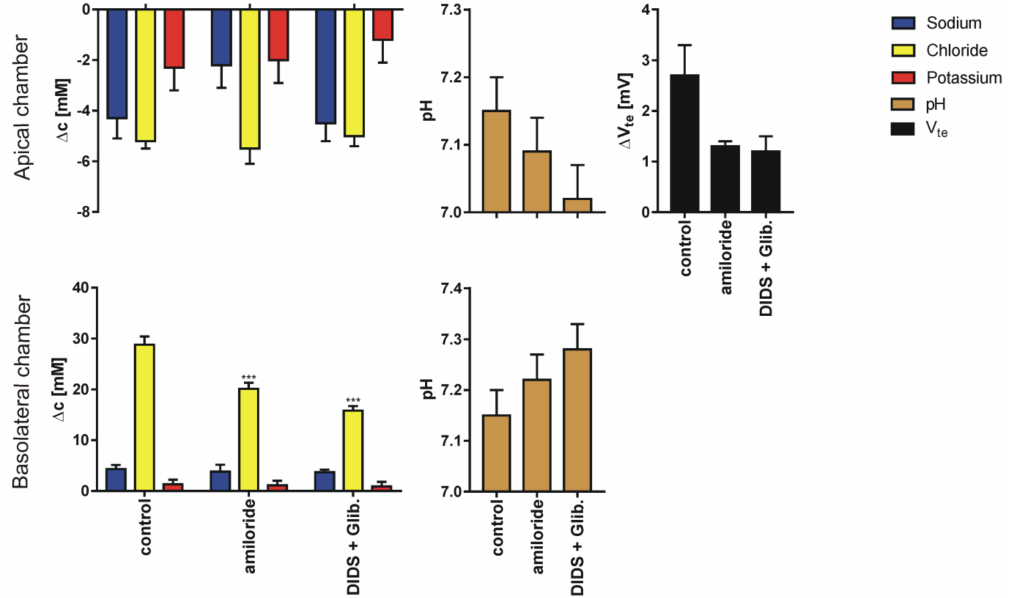
Figure 6. The results (Mean ± SD) of experiments performed in reversed chloride gradient (apical side, KHS1; basolateral side, KHS3) in control conditions and after supplementation of the solution with ion channel blockers. The graph represents: sodium, chloride, potassium transport across epithelial cell monolayer expressed as the concentration change measured 10 min after appropriate solution flow stop; final pH value and the transepithelial potential di ff erence change (N = 10–13 for Cl − , Na + and V te , N = 5 for K + and pH, dependent sample t-test, * p < 0.05, ** p < 0.01, *** p < 0.001). Note di ff erent scales for apical and basolateral